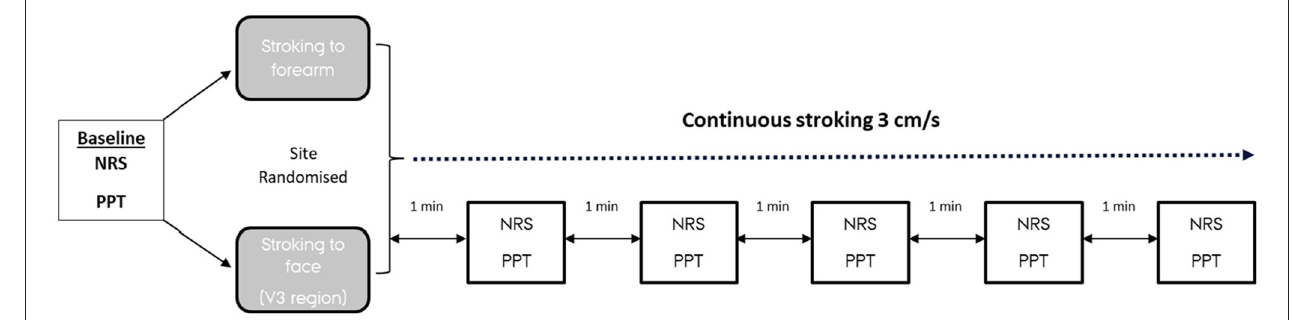
FIGURE 2 | Schematic representation of the experimental design. The velocity randomized would be used for the entire session, in this example 3 cm/s, with 30 cm/s to be used at the second session. NRS, numerical rating scale (0–100 for pleasantness and unpleasantness); PPT, pressure pain threshold (to hypothenar muscle).